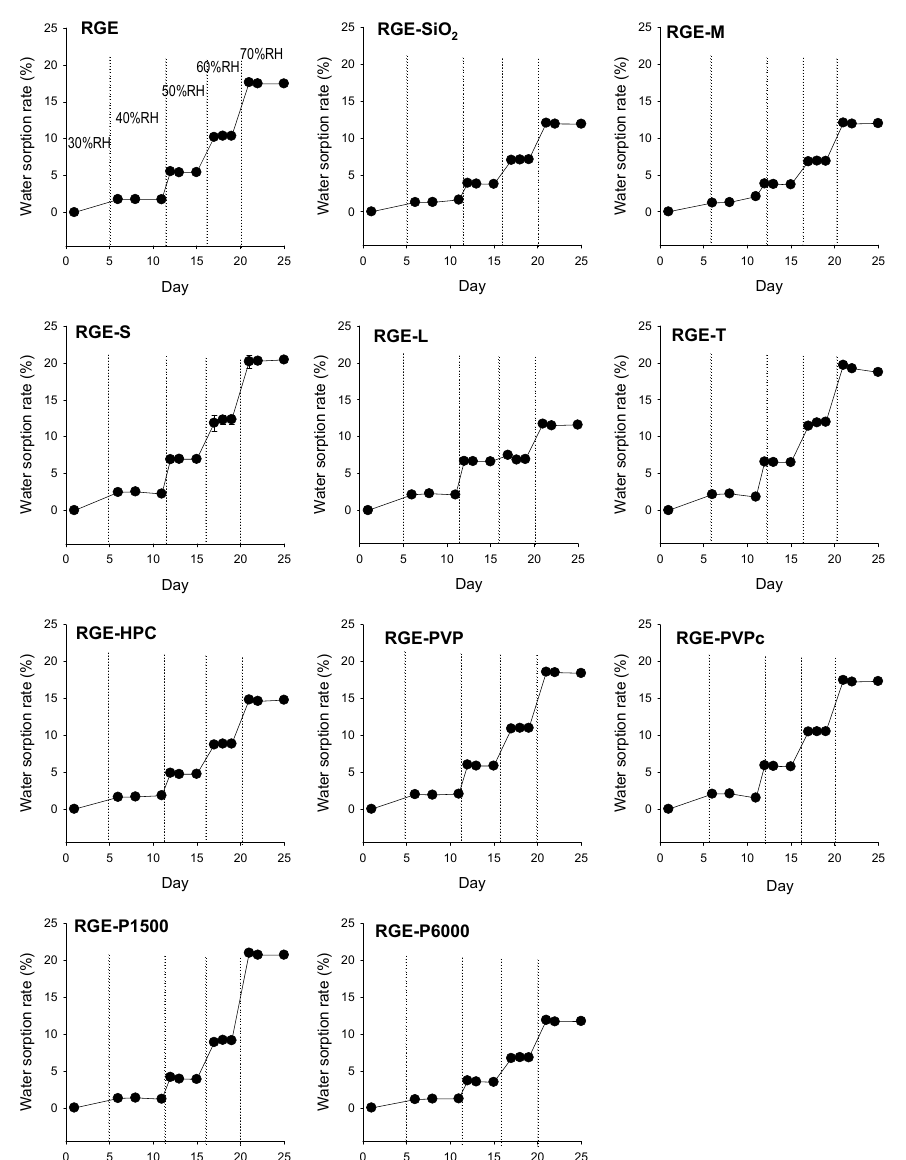
Figure 2. The effect of humidity (from 30% RH to 70% RH) on the water sorption rate of solid dispersion of red ginseng extract (RGE) stored in a thermo-hygrostat at 30 ◦ C. Data represent the mean ± standard deviation ( n = 3). RGE: solid dispersion of red ginseng extract; RGE-SiO 2 : solid dispersion of RGE with silicon dioxide; RGE-M: solid dispersion of RGE with mannitol; RGE-S: solid dispersion of RGE with sucrose; RGE-L: solid dispersion of RGE with lactose; RGE-T: solid dispersion of RGE with trehalose; RGE-HPC: solid dispersion of RGE with hydroxypropyl cellulose; RGE-PVP: solid dispersion of RGE with polyvinyl pyrrolidone; RGE-PVPc: solid dispersion of RGE with cross-linked polyvinyl pyrrolidone; RGE-P1500: solid dispersion of RGE with PEG1500; RGE-P6000: solid dispersion of RGE with PEG6000.